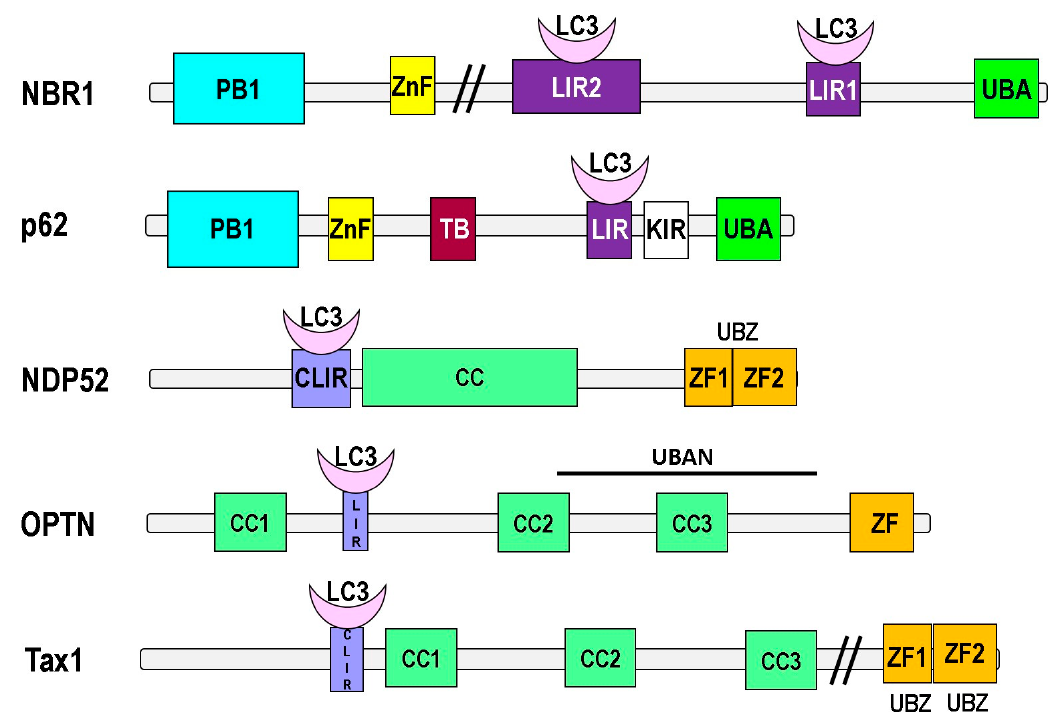
Figure 3. Autophagy adaptors. Ubiquitin recognition receptors are multiple in nature, but they share common areas that serve to recognize and bind to ubiquitin, and areas that allow recruitment of LC3 for the autophagophore. The receptors depicted are Neighbor of BRCA1 Gene 1 (NBR1), Ubiquitin-Binding Protein P62 (p62), nuclear dot protein 52; also known as calcium binding and coiled-coil domain 2 [CALCOCO2] (NDP52), optineurin (OPTN), Tax1-binding protein 1 (Tax1), Toll-Interacting Protein (TOLLIP), and NIX / BNIP3L [BCL2 / adenovirus E1B 19 kDa interacting protein 3-like] (NIX/BNIP3). The ubiquitin binding domains are: ubiquitin-associated domain (UBA), Ubiquitin binding in ABIN and NEMO domain (UBAN), Ubiquitin-binding zinc finger domain (UBZ), Endoplasmic reticulum-associated degradation domain (Cue). The LC3 recruiting domains are: LC3-interacting region (LIR), non-canonical LIR motif (CLIR), and LC3 recognition sequence (LRS).